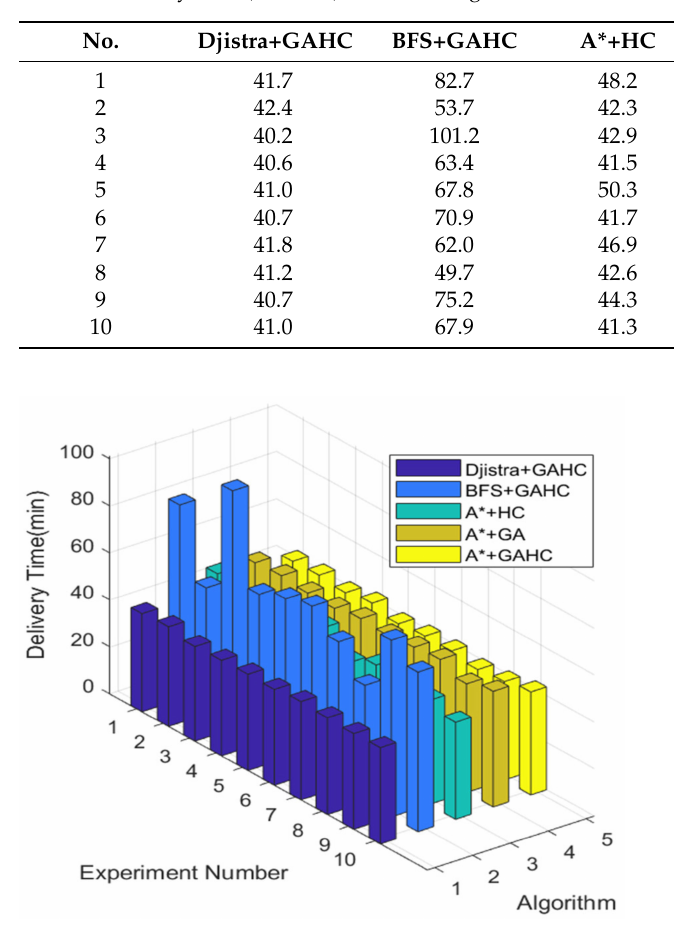
Figure 14. Delivery time in various algorithms.